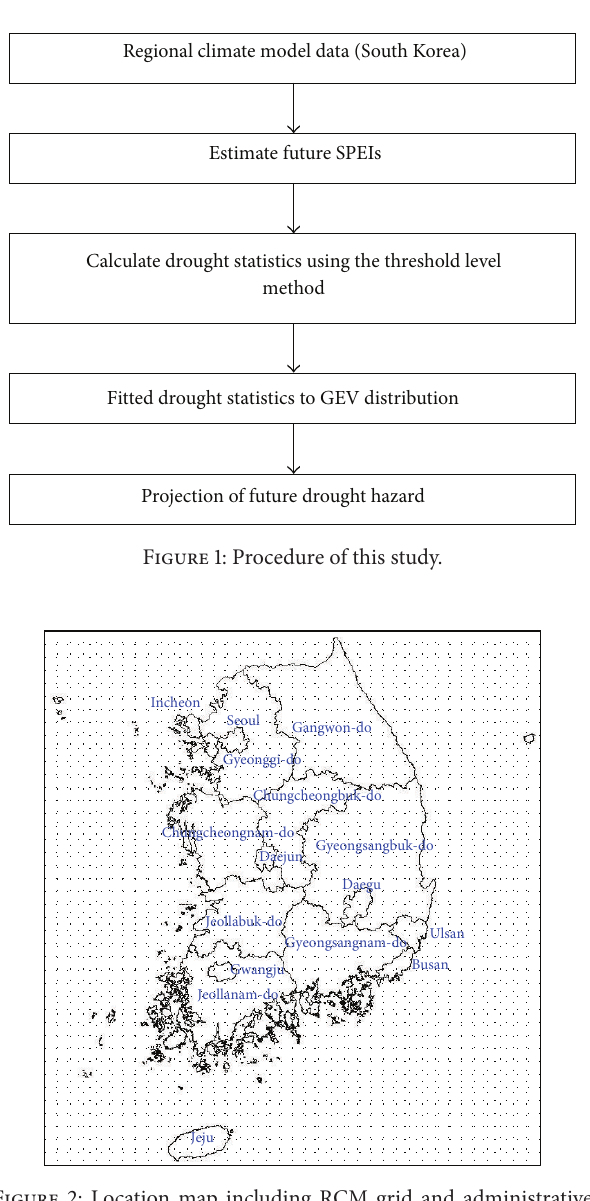
Figure 2: Location map including RCM grid and administrative division.